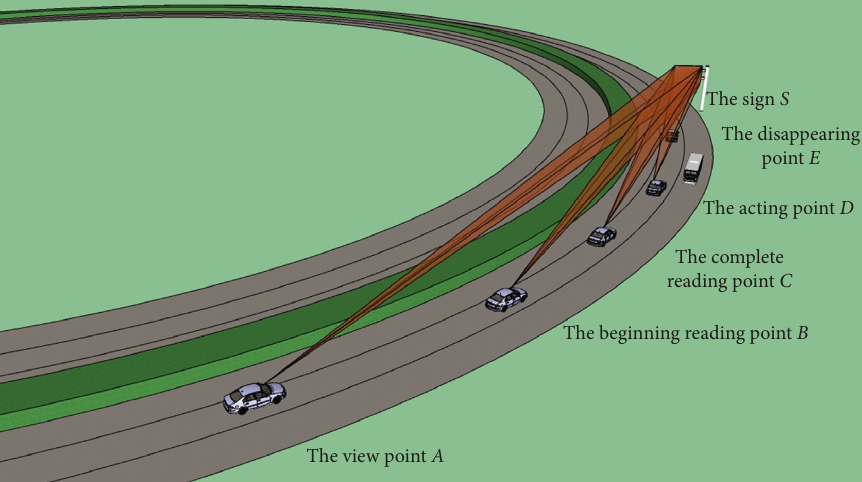
Figure 9: Simulation diagram of the affected visibility window at the outer curve (for details, refer to the